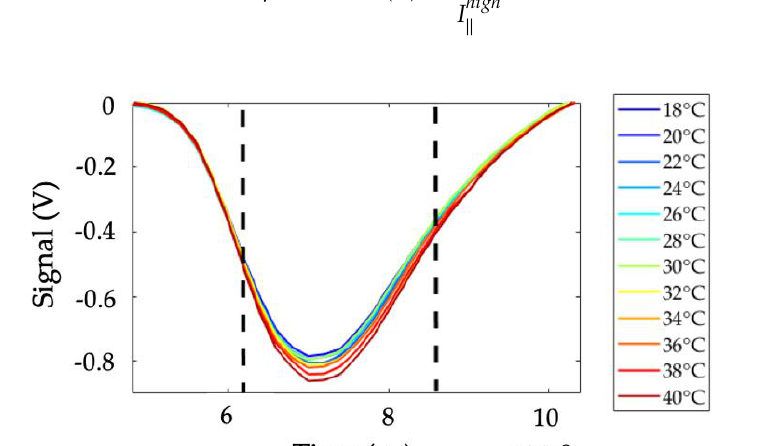
Figure 3. Band pass filter transmissions superimposed on (a) parallel and (b) perpendicularly- polarized Raman spectra. Low and high channels are indicated by shaded areas.